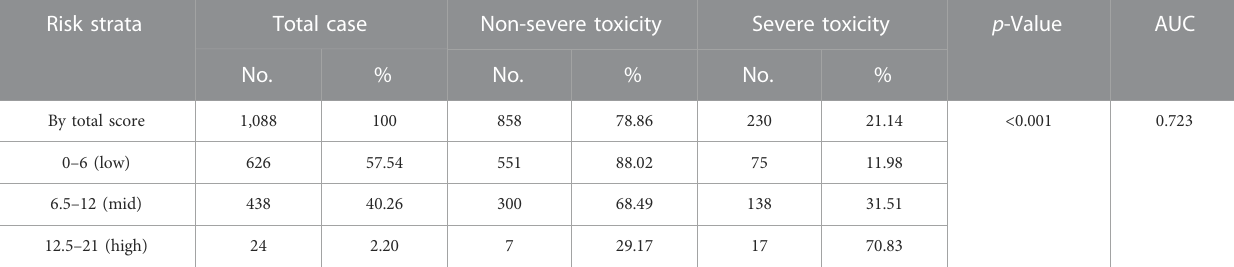
TABLE 5 Ability of risk score to predict chemotherapy